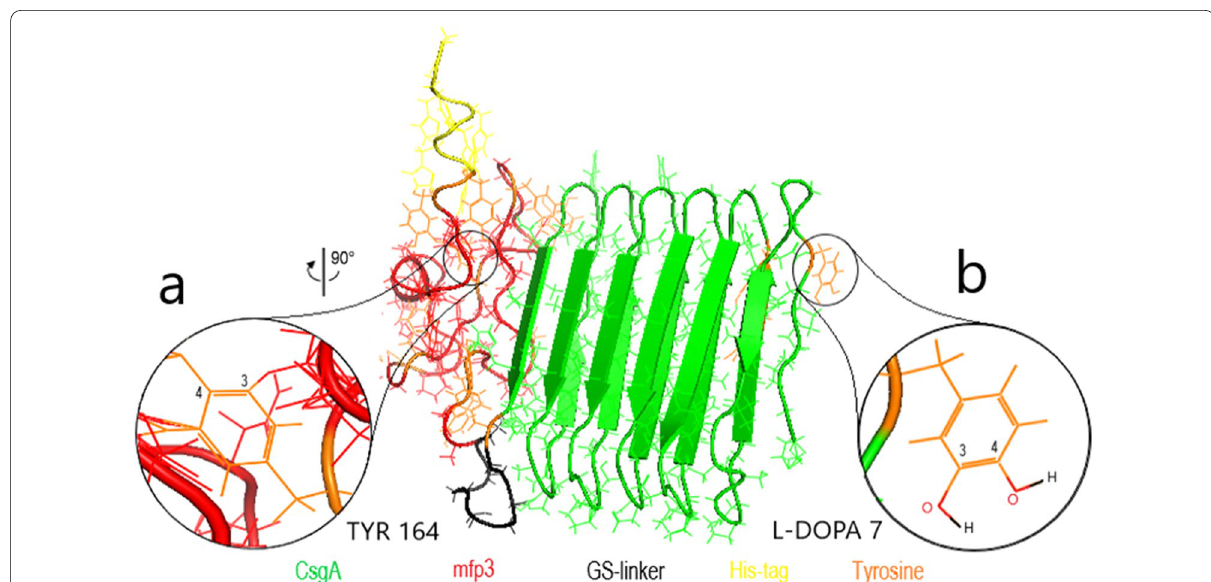
Fig. 7. 3D structure of the fused CsgA-MFP3 protein and manual modification in PyMOL. a A tyrosine involved in the MFP3 chain of the chimeric protein; The carbon numbers 3 and 4 of the benzene rings were bound to other internal amino acids and could not be counted as a tyrosinase substrate. b l -DOPA; a product of the tyrosinase enzymatic reaction on available